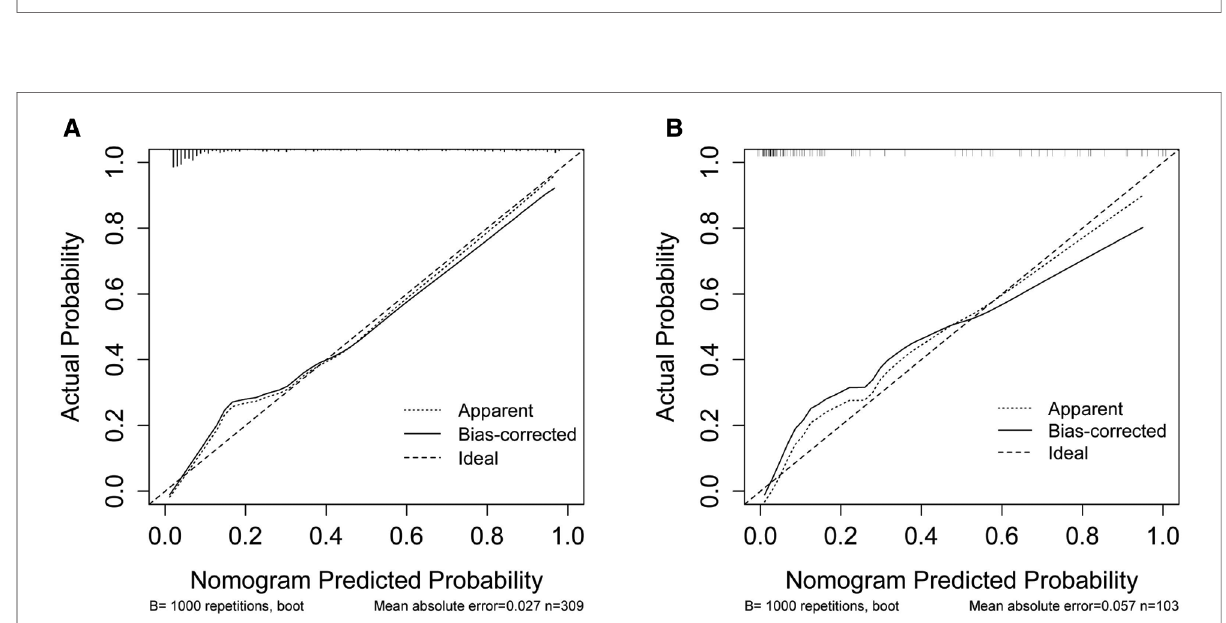
FIGURE 5 Calibration curves of the moderate and severe BPD risk nomogram. The y -axis represents actual diagnosed cases of moderate and severe BPD, the x - axis represents the predicted risk of moderate and severe BPD. The diagonal dotted line represents a perfect prediction by an ideal model, the solid line represents the performance of the moderate and severe BPD risk nomogram in the training set ( A ) and validation set ( B ), with the results indicating that a closer fi t to the diagonal dotted line represents a better prediction. BPD, bronchopulmonary